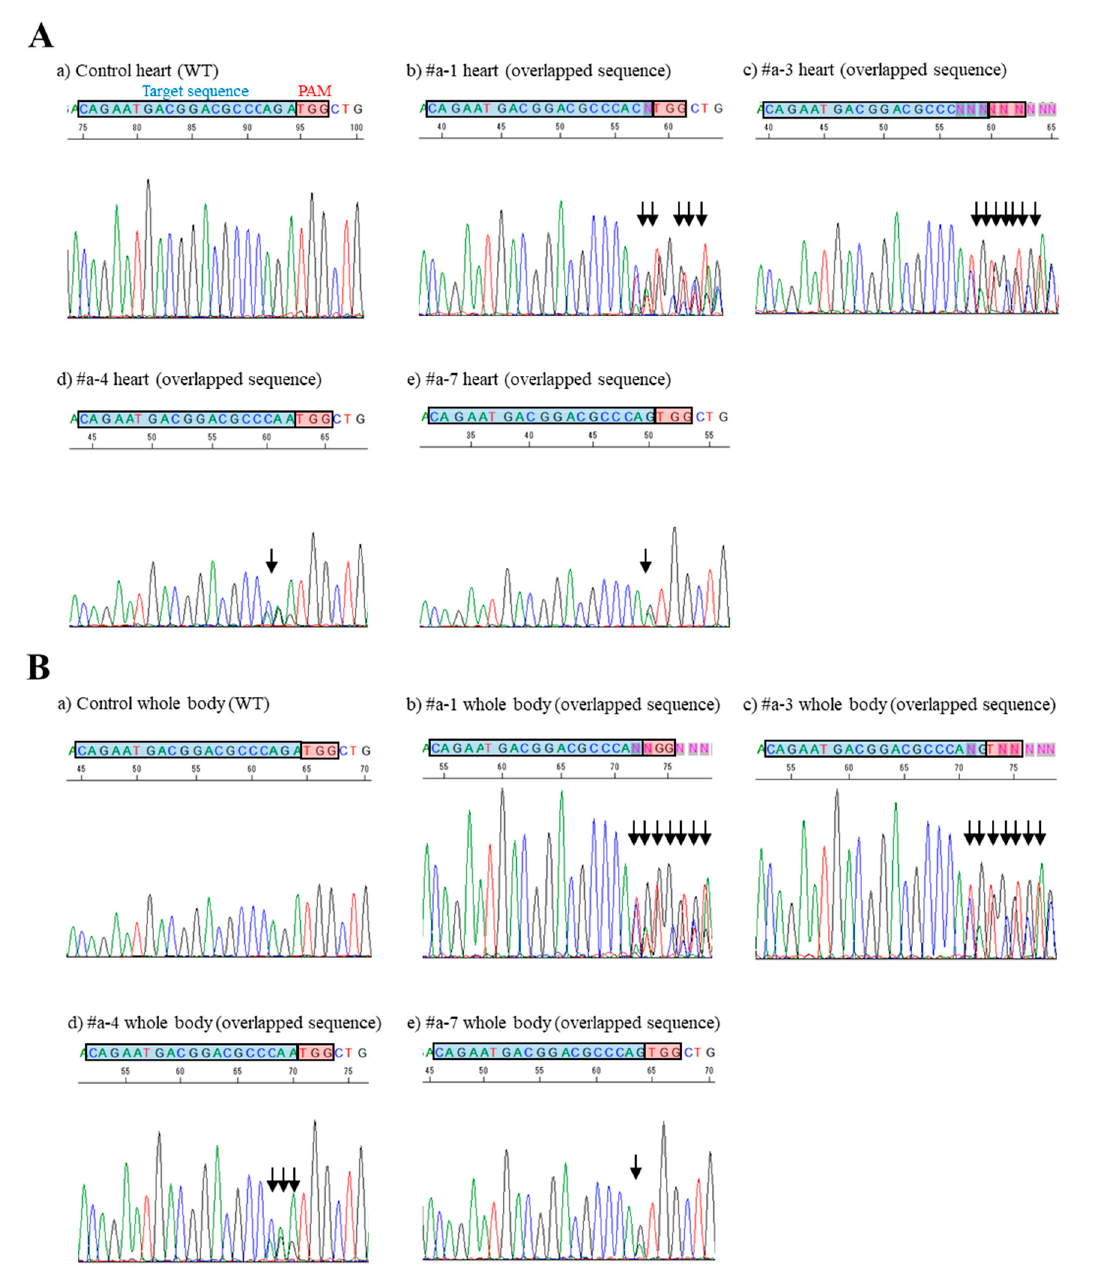
Figure 3. Sequence analysis of PCR products (corresponding to the endogenous MHC α gene exon 1) derived from HGD-based TPGD-GEF-treated fetuses. ( A ) Direct sequencing of PCR products obtained from fetal hearts (WT and #a-1, -3, -4, and -7). In a) control heart, the sequence enclosed by a quadrant filled with blue (corresponding to the target sequence recognized by gRNA targeting MHC α sequence) remained unaltered. By contrast, in b) #a-1, c) #a-3, d) #a-4, and e) #a-7, overlapping electrophoretograms (indicated by arrow) are notable immediately upstream of the PAM, indicating the presence of genome-edited and unedited sequences. The PAM (TGG) is shown as a quadrant filled with red. WT, wild-type. ( B ) Direct sequencing of PCR products obtained from murine fetal whole bodies (fetal portion except for heart) (WT and #a-1, -3, -4, and -7). There is a similar pattern of electrophoretograms as shown in A .